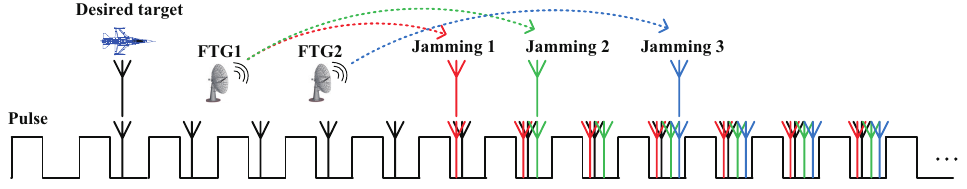
Figure 1. Schematic diagram of generating pseudo-randomly distributed range deceptive